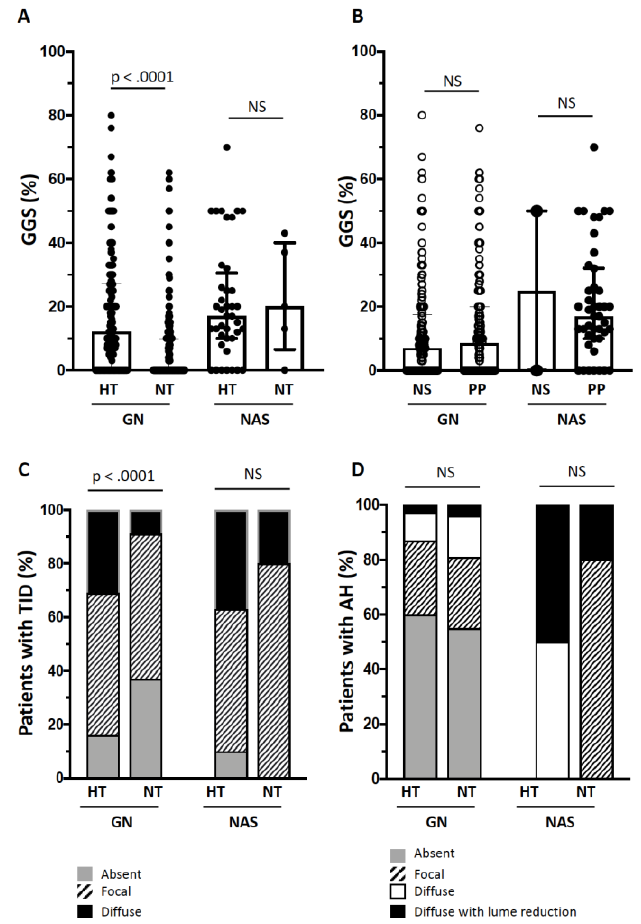
Figure 2. Global glomerulosclerosis (GGS%) in the patients with hypertension (HT) or normal blood pressure (NT) in the subgroups of glomerulonephitis (GN) and nephroangiosclerosis (NAS) (Panel A ). GGS% in the patients with nephrotic syndrome (NS) or persistent proteinuria (PP) in the subgroups of GN and NAS (Panel B ). Prevalence of tubulointerstitial damage (TID) or arteriolar hyalinosis (AH) scores in the HT or NT patients in the subgroups of GN and NAS (Panels C and D , respectively). TID score increased along with GGS% in GN patients (Figure 3), and this trend was seen in patients with or without hypertension, with or without nephrotic syndrome (Figure